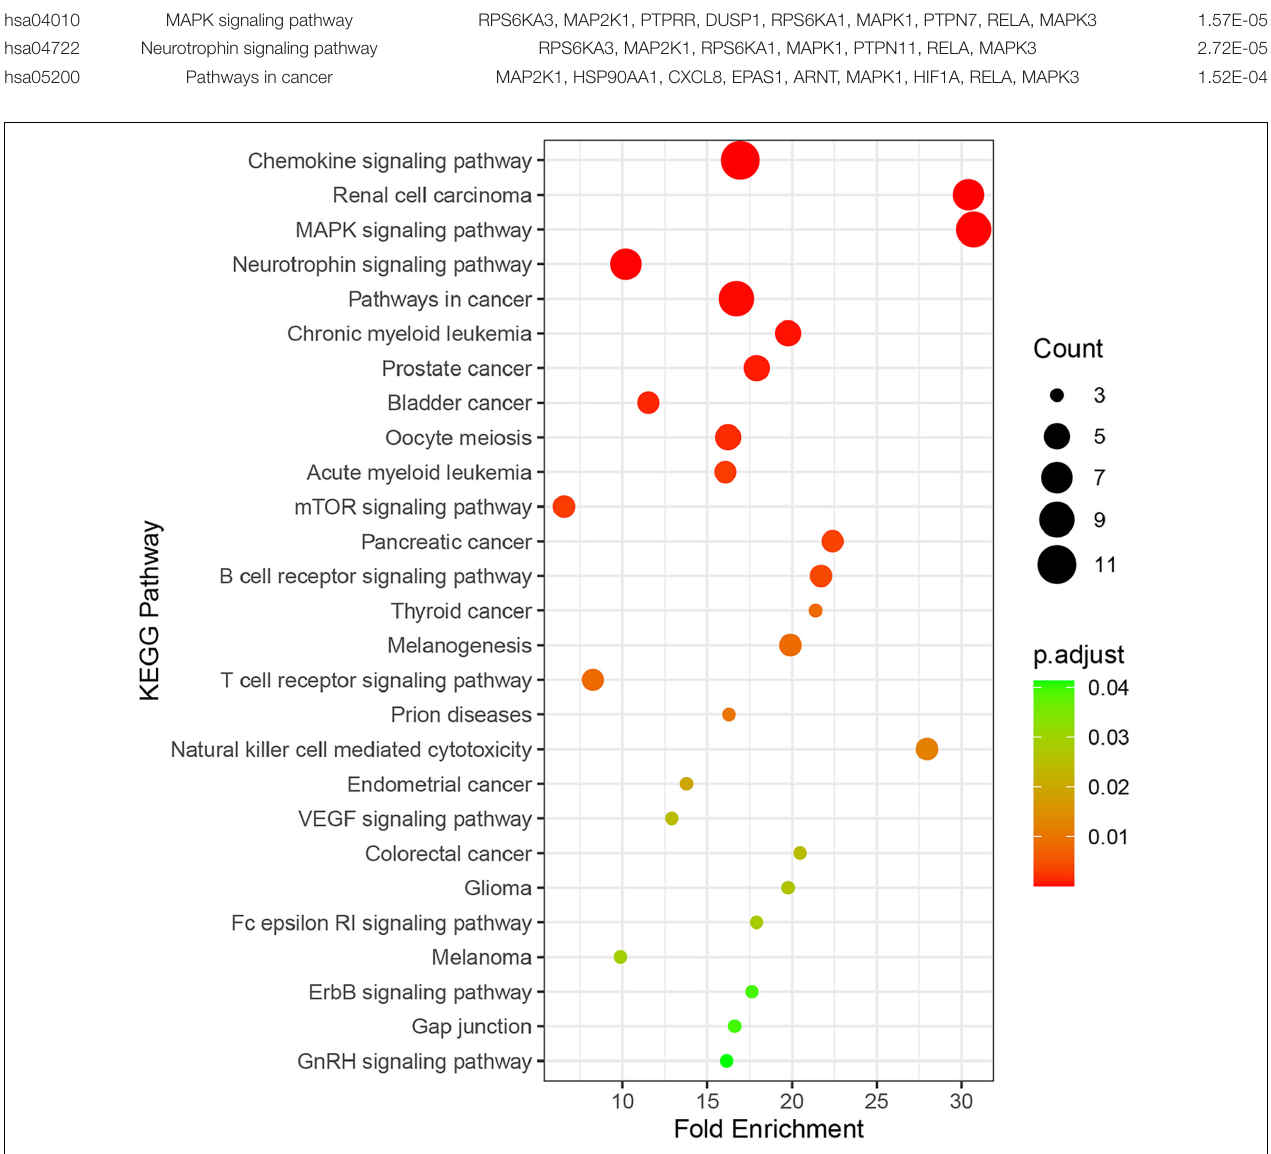
FIGURE 3 | Enrichment information of KEGG pathways with p .adjust < 0.05. Top five KEGG pathways were the Chemokine signaling pathway (hsa04062), Renal cell carcinoma (hsa05211), the MAPK signaling pathway (hsa04010), the Neurotrophin signaling pathway (hsa04722), and Pathways in cancer (hsa052009).